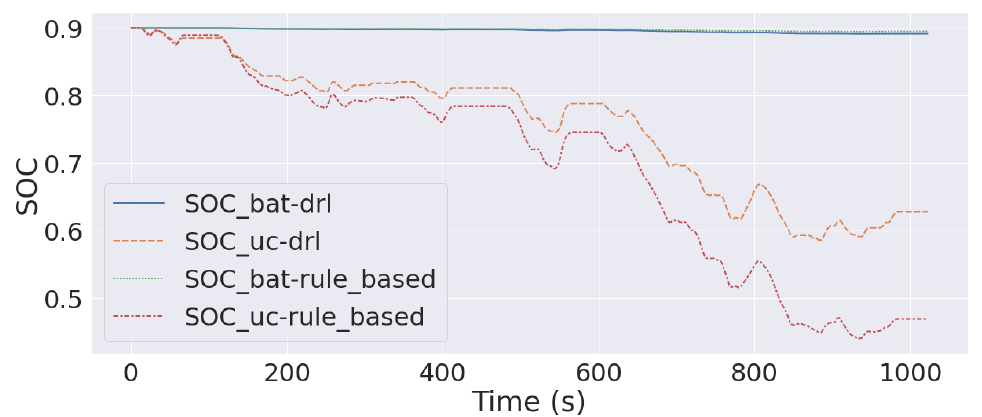
Figure 13. Comparison of SOCs obtained by rule-based and DRL technique when the initial SOCs are